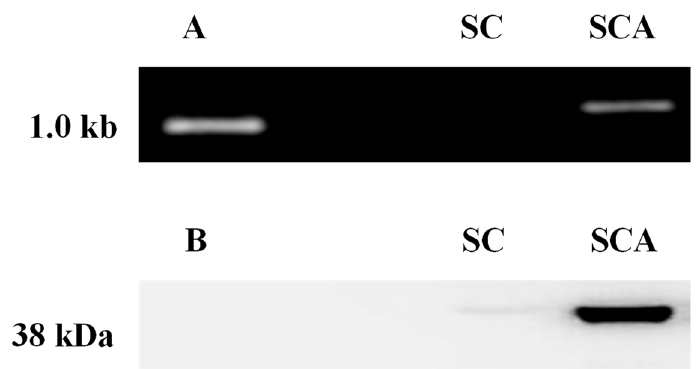
Figure 3. ( A ) PCR confirmation of the recombinant expression vector pGAPZC-ari1 in SC and SCA. ( B ) Overexpression of ARI in SC and SCA. SC ( S. cerevisiae ) and SCA ( S. cerevisiae with ari1 gene overexpression).